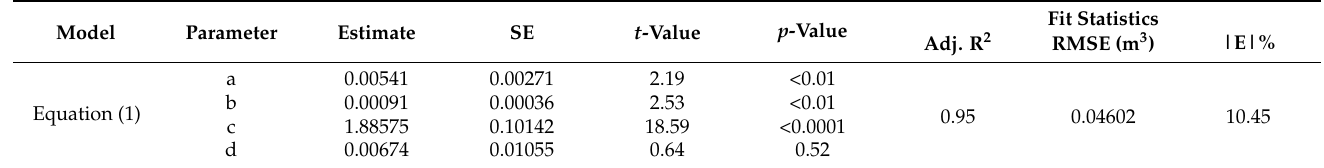
SE standard error, RMSE root mean square error, |E|% mean percentage error. Table A2. Parameters and fit statistics for model Equation (2) to estimate the cumulative trunk diameter and wood volume of P. patula unthinned (Nthi) and thinned (Thi) trees.